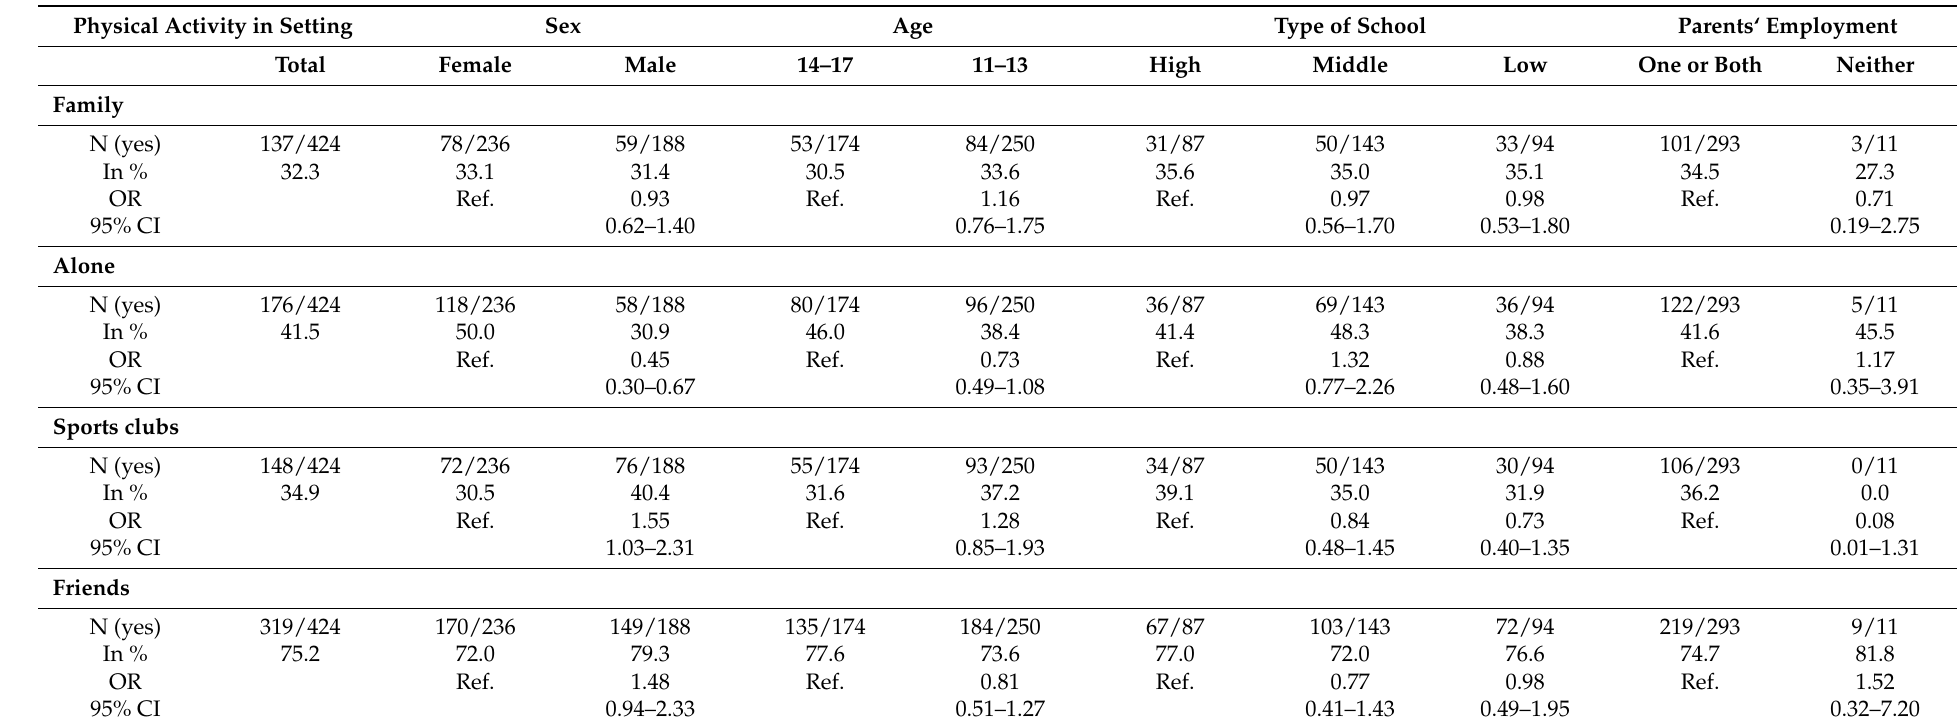
Table 1. Indicators and statistics on activity behavior by sociodemographic